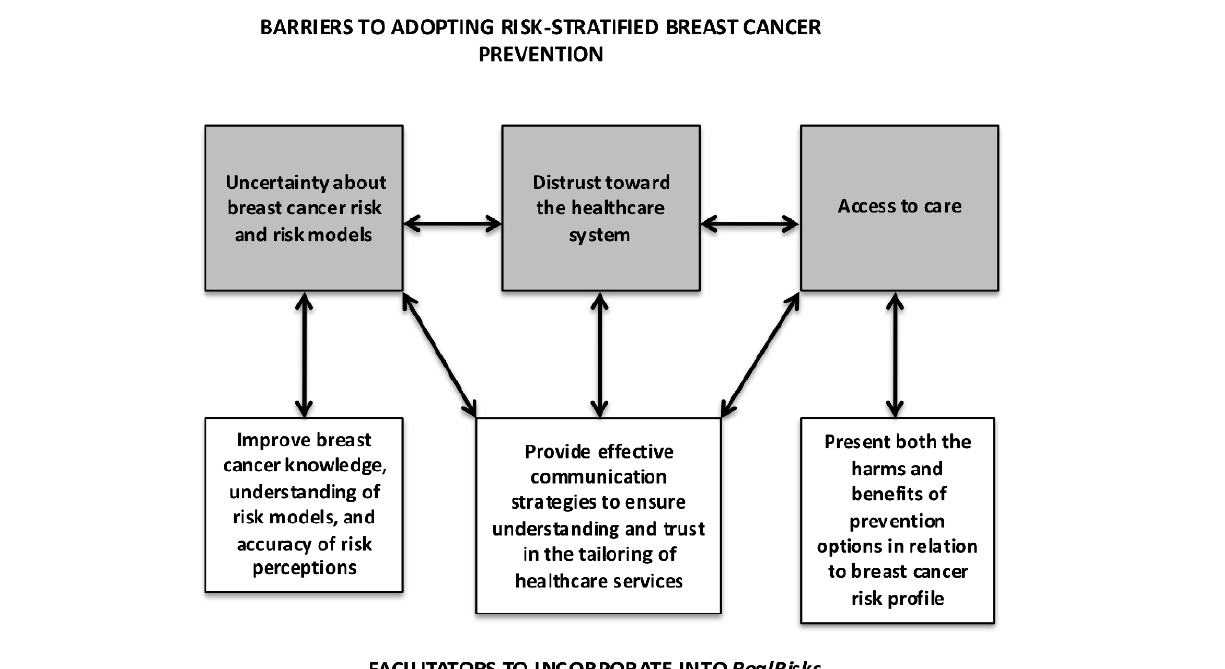
Figure 2. Schema of barriers and facilitators to the adoption of breast cancer risk assessment and risk-appropriate prevention strategies, which will inform the iterative design and refinement of the RealRisks decision